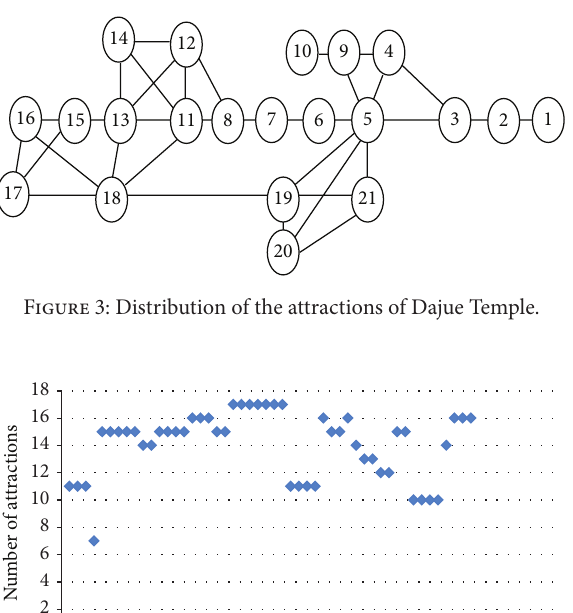
Physical exercise, 0.13